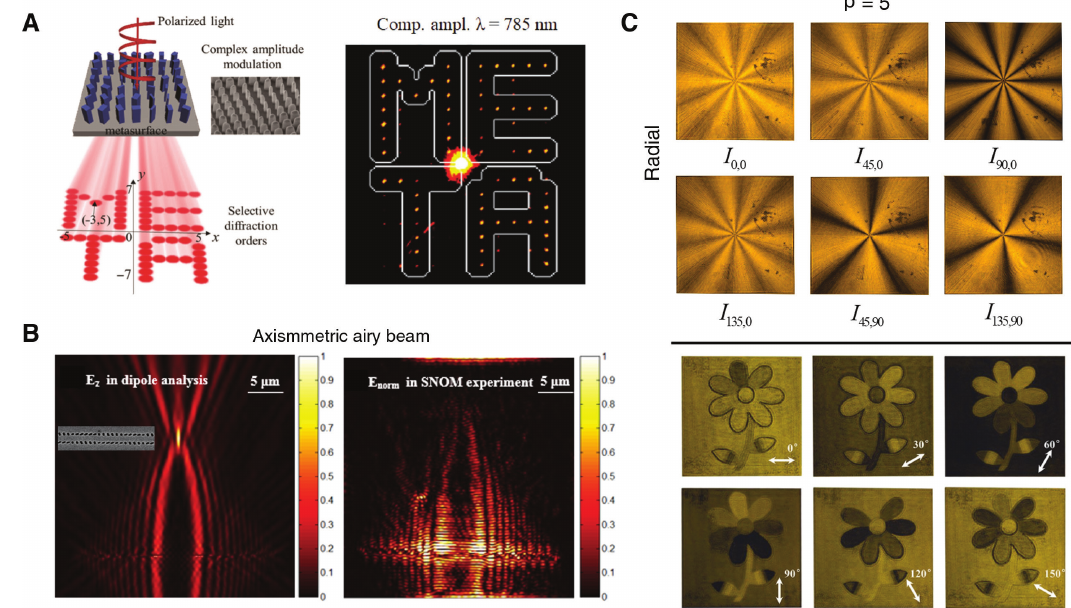
Figure 3: Wavefront and polarization modulation by metasurfaces. (A) Schematic illustration and experimental results of the complex amplitude modulation for arbitrary two-dimensional diffraction order distribution with a dielectric metasurface [95]. (B) Near-field plasmonic beam engineering with complex amplitude modulation based on metasurface [96]. (C) The measured intensity distributions of the high-order radial polarization beams generated by the metasurface composed by silicon nanofins and the polarization encryption images based on such metasurface